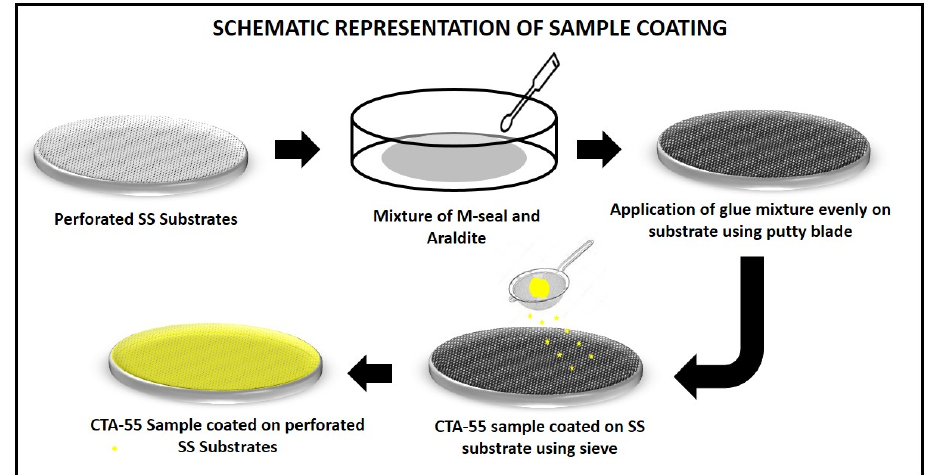
Figure 1. Schematic representation of CTA-55 sample-coating technique.